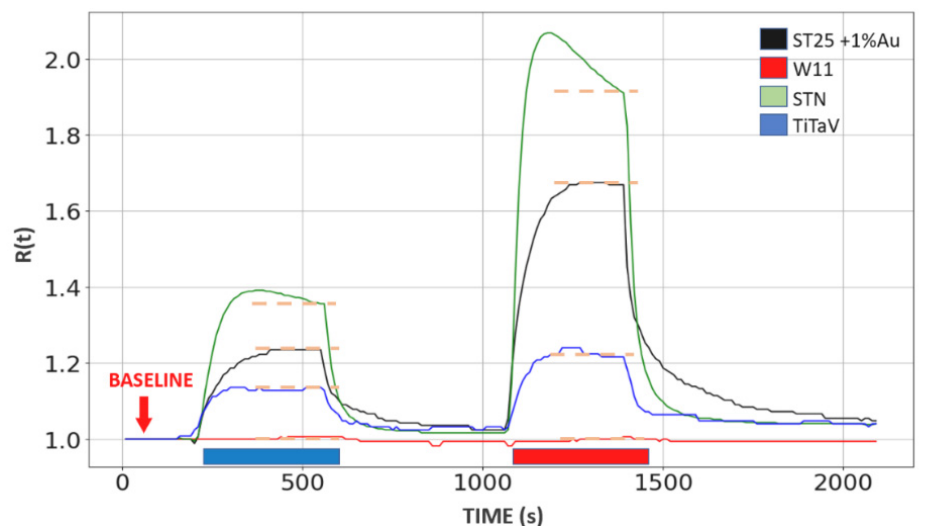
Figure 2. Computed response amplitude of the four sensors. The ST25, W11, STN and TiTaV sensor responses (represented by black, red, green and blue curves, respectively) to the HB exhalation (thick blue line) and of a TB one (thick red line); average steady state amplitudes are shown by the orange dotted lines.